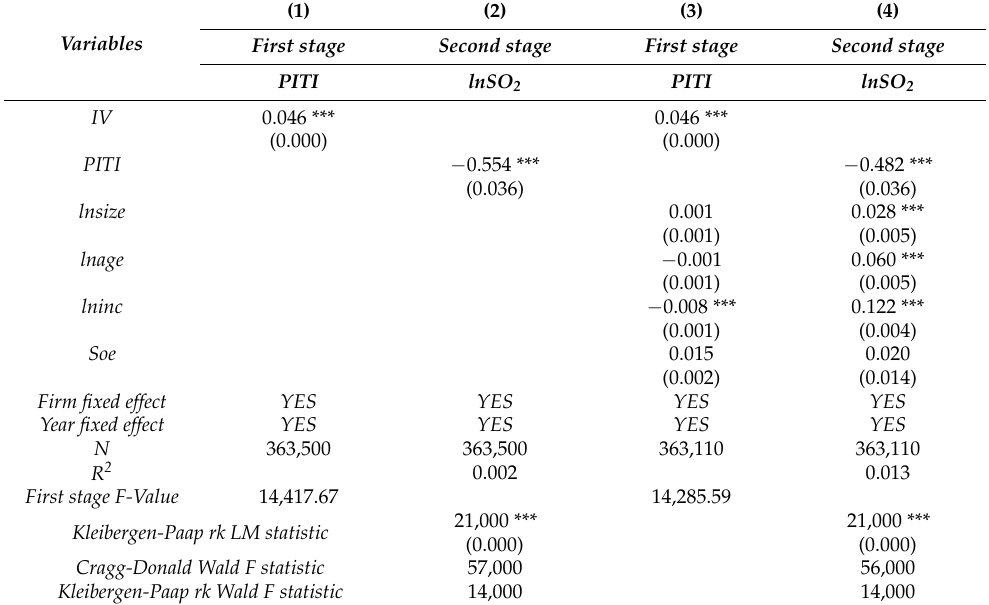
Table 4. Test of Instrumental